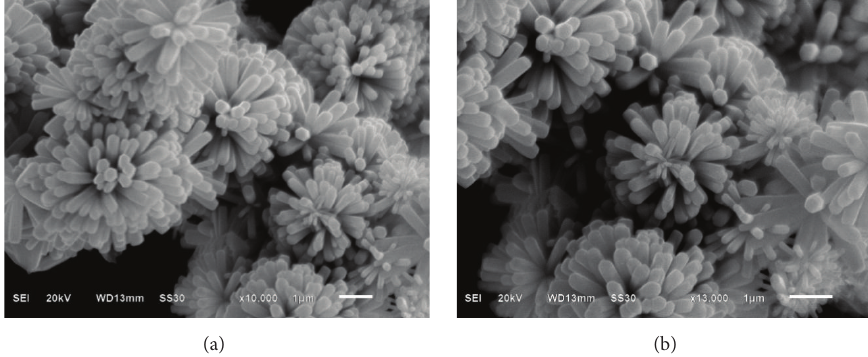
Figure 5: Micrograph of ZnO-SiO 2 using 2.0 M NH 4 OH showing flower-like ZnO-SiO 2 nanostructures having hemispherical tips. At (a) 10,000x magnification and (b) 13,000x magnification.